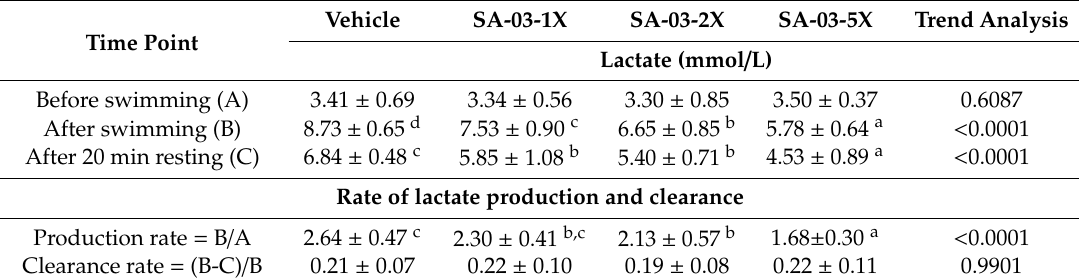
Table 2. E ff ect of SA-03 on lactate